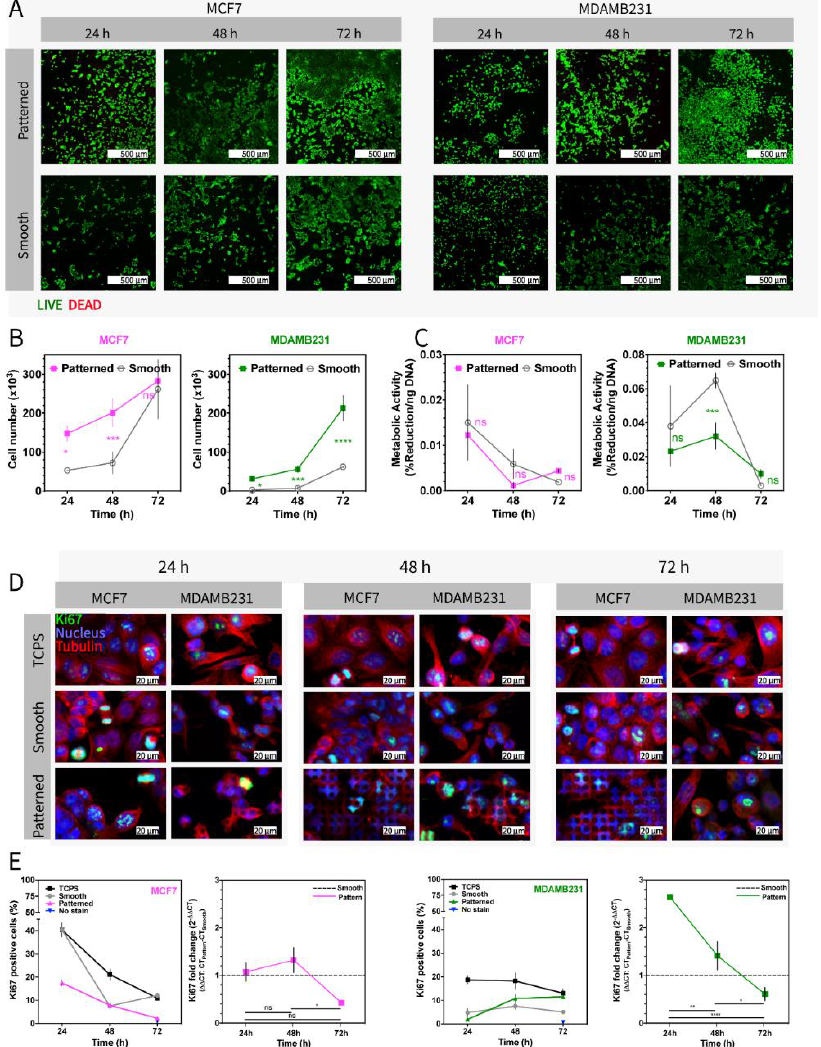
Figure 3. Live–Dead, cell number, metabolic activity, proliferation index (Ki-67 positive cell ratio) and Ki-67 gene expression of the MCF7 and MDAMB231 cells on Ch-Pattern and Ch-Smooth chips. ( A ) Live–Dead assay of MDAMB231 and MCF7 cells cultured on Ch-Pattern and Ch-Smooth for 72